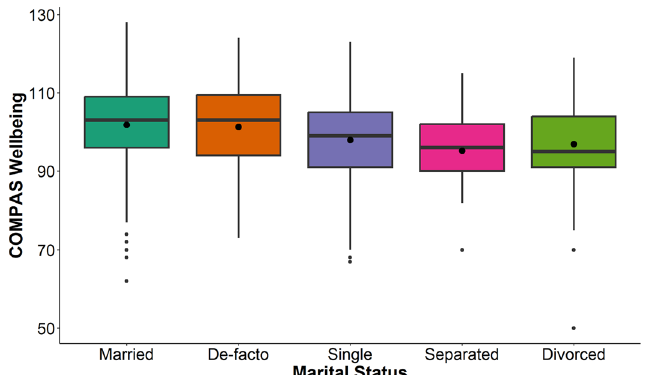
Figure 2. Boxplot showing relationship between marital status and mental wellbeing. Mean wellbeing is indicated by circles inside each boxplot. Pairwise comparisons found that de-facto individuals had higher average wellbeing than singles, and that married individuals had higher average wellbeing than singles, divorcees, and separated